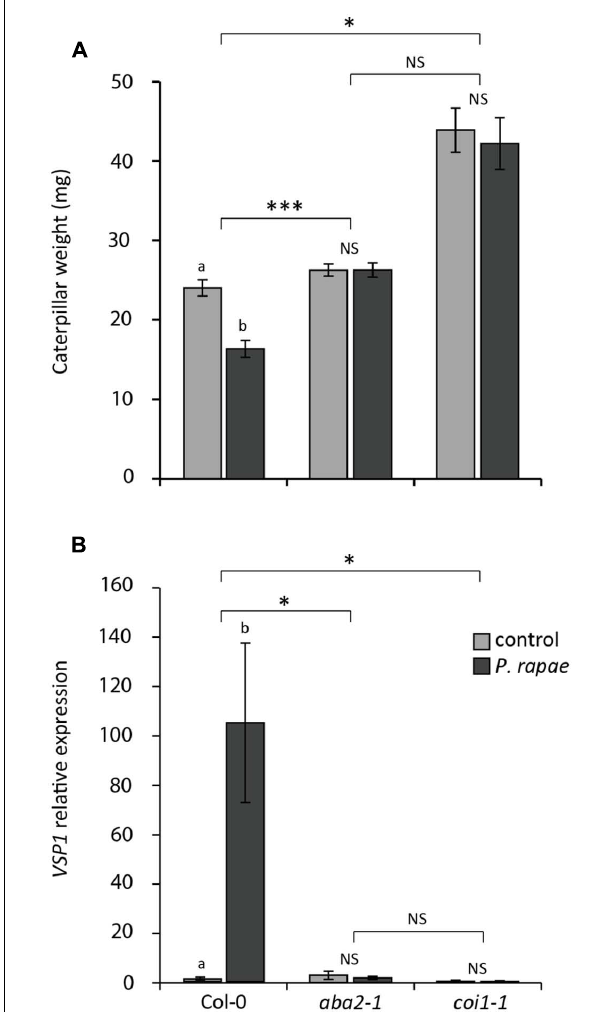
FIGURE 4 | Effect of herbivory on P. rapae performance on Col-0, aba2-1 , and coi1-1 plants. (A) Growth of P. rapae larvae on herbivore-induced ( P. rapae ) and uninduced (control) Col-0, aba2-1 , and coi1-1 plants. A first-instar larva was allowed to feed for 24 h after which it was removed. Another 24 h later, a new first-instar larva was placed onto uninduced plants and P. rapae -induced plants. Caterpillar fresh weight was measured after 7 days of feeding. Feeding of a single first-instar larva for 24 h caused only minor chewing damage on usually one leaf, leaving ample tissue on all the plant genotypes for the subsequent larva to feed on for 7 days.The values presented are means ( ± SE) of 30–36 larvae that fed on similarly treated plants. Different letters indicate statistically significant differences between performance on control (non-pre-infested) and herbivore-pretreated plants per genotype ( P < 0.05; NS, not significant); asterisks indicate statistically significant interaction between genotype × treatment (* P < 0.05; *** P < 0.001). Data were analyzed using two-way ANOVA. (B) RT-qPCR analysis of VSP1 transcript levels (relative to non-infested Col-0) in non-infested (control) and P. rapae -infested ( P. rapae ) Col-0, aba2-1 , and coi1-1 plants. First-instar larvae were allowed to feed for 24 h after which they were removed and damaged leaves were harvested for analysis. Depicted are the average expression levels ( ± SE) of three biological replicates, consisting of five leaves each. Different letters indicate statistically significant differences between control and treatment of one genotype ( P < 0.05; NS, not significant); asterisks indicate statistically significant interaction between genotype × treatment (* P < 0.05). Data were analyzed using two-way